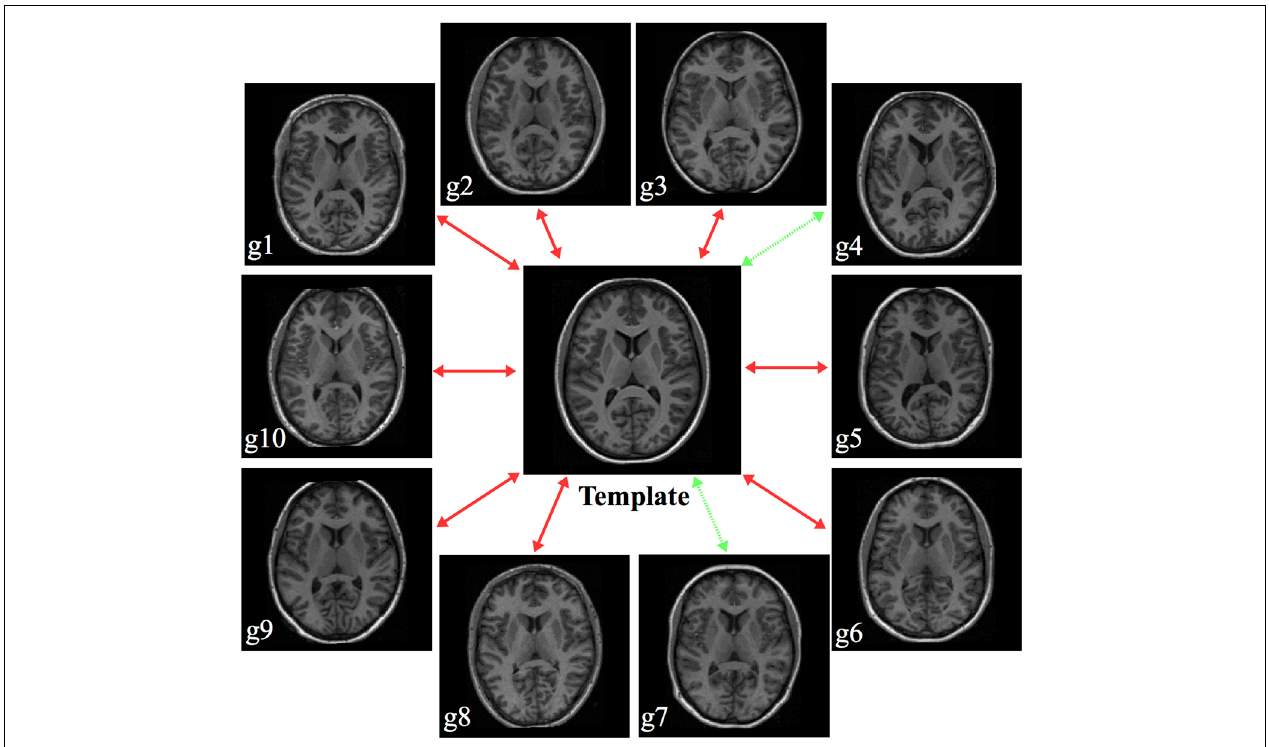
FIGURE 3 | Illustration of generating a pseudo-geodesic for any two subjects within the MGH10 cohort. Once the transforms between the template and each subject are calculated, the mapping between any two subjects is found by composition of forward and inverse transforms. For